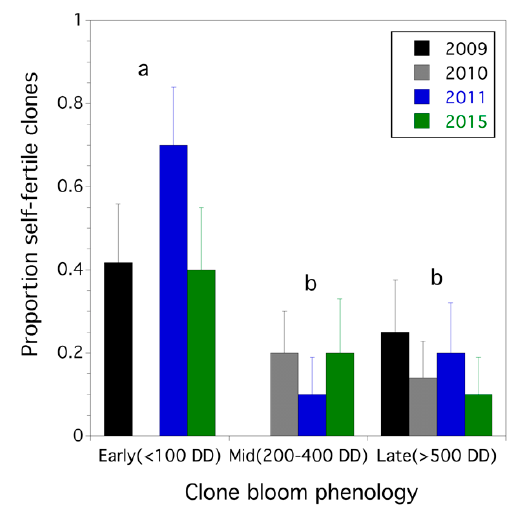
Figure 1. The proportion of highly self-fertile clones according to the period in bloom that they begin to flower (early, mid, and late bloom). Letters associated with bloom phenology classes that are the same are not significantly di ff erent (Tukey HSD, α = 005).